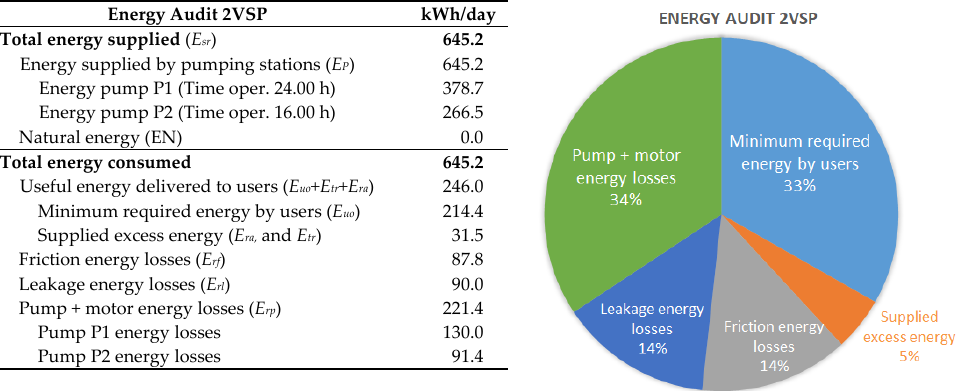
Figure 7. Energy audit result of the initial system with two VSP.